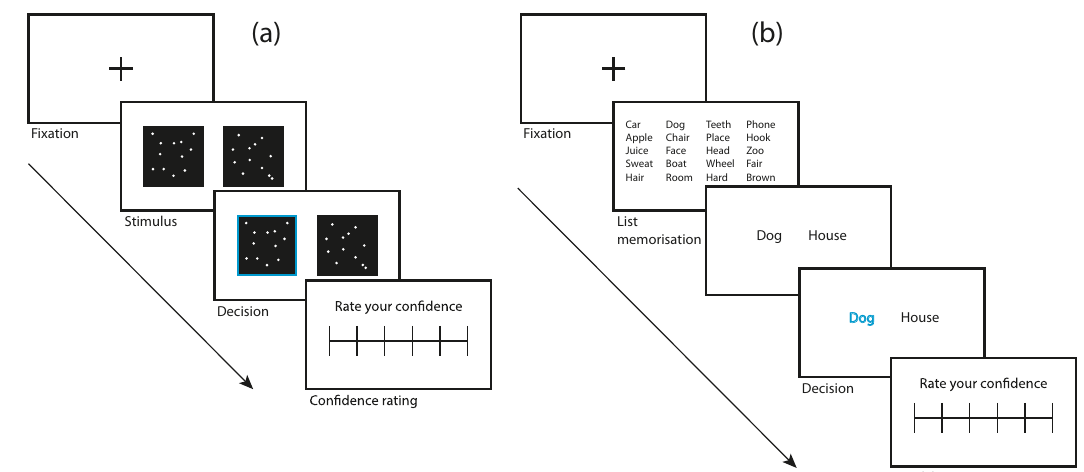
Fig. 2 Examples of 2-AFC tasks with the addition of post-decisional con fi dence judgement used to assess meta-knowledge. a Visual perception task: subjects choose the box containing the most (randomly generated) dots. Subjects then rate their con fi dence in their decision. b Memory task: subjects learn a list of words. In the next screen, they have to identify which of two words shown was present on the list. The subjects then rate their con fi dence in their